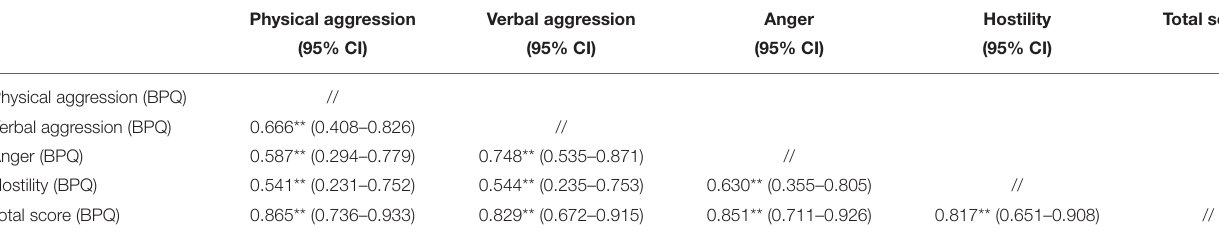
TABLE 3 | Correlations between scores of the Buss Perry subcategories.